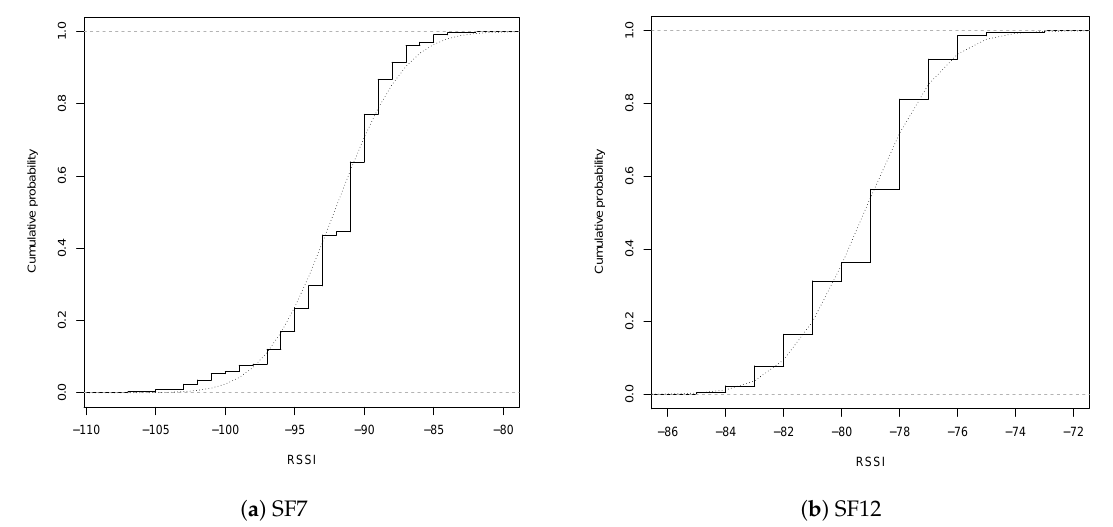
Figure 9. Cumulative distribution of the RSSI with two different spreading factors at 50 m.